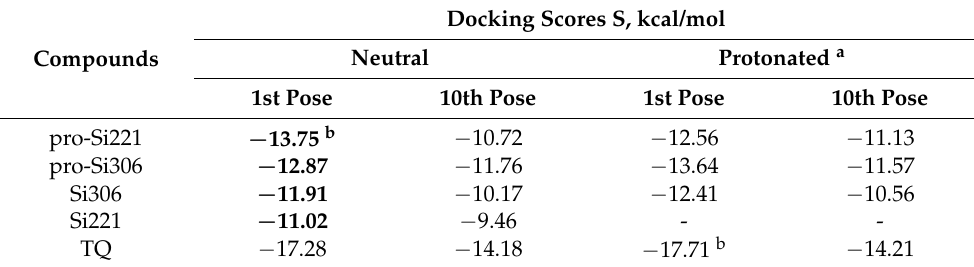
Table 4. Scores (S) obtained from the docking of the studied compounds into the binding cavity of